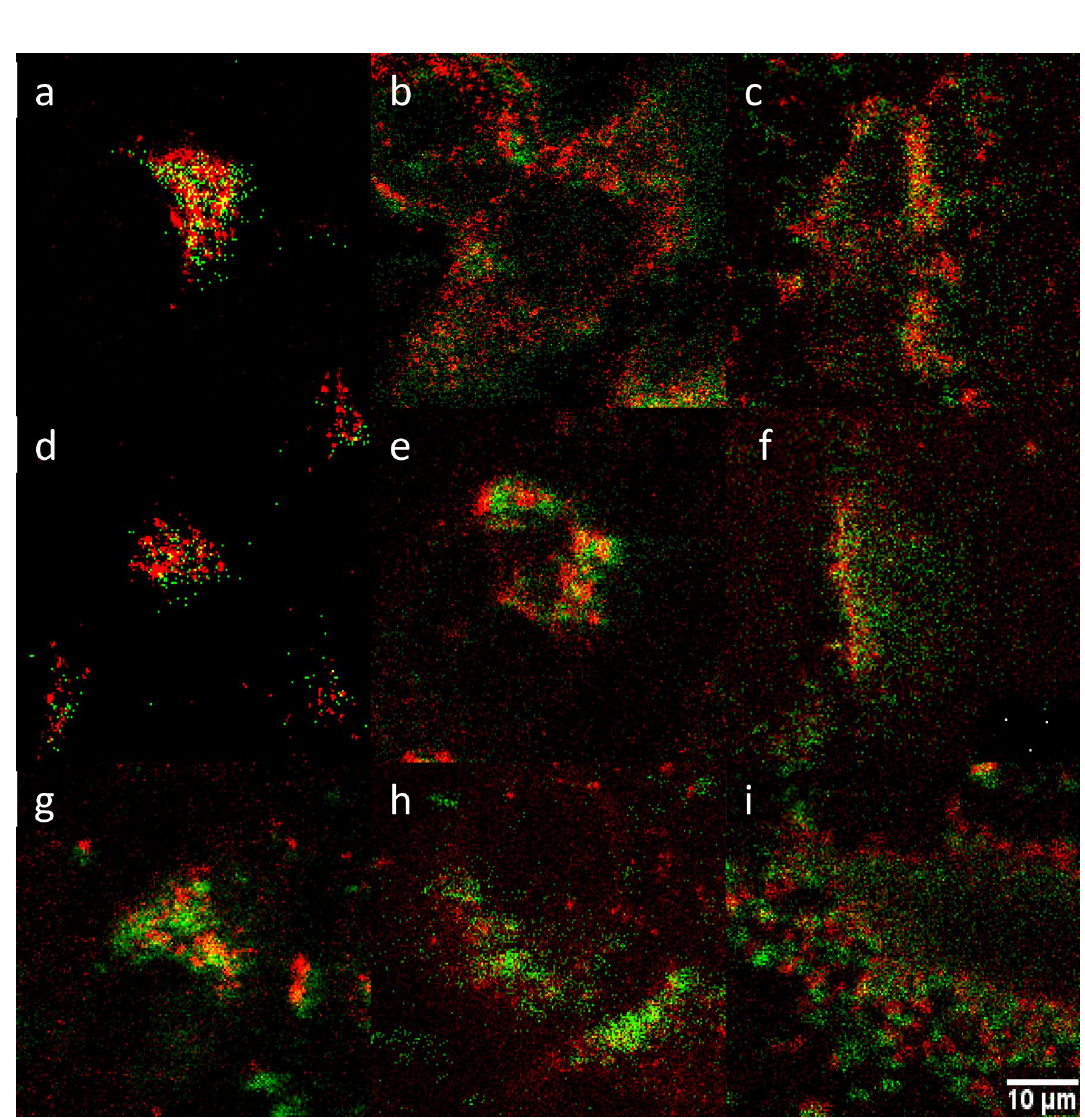
Figure 9. Overlay of luminescence of ( a – c ) CS-UCNP@Ale-P(DMA-AEC)-DY-615, ( d – f ) CS-UCNP@ Ale-PDMA-DY-615, and ( g – i ) CS-UCNP@Ale-P(DMA-AMPS)-DY-615 with DY-615 in ( a , d , g ) HeLa, ( b , e , h ) HepG2, and ( c , f , i ) INS-1E cells. Excitation of the particles (green) and DY-615 (red) at 980 and 621 nm, respectively.